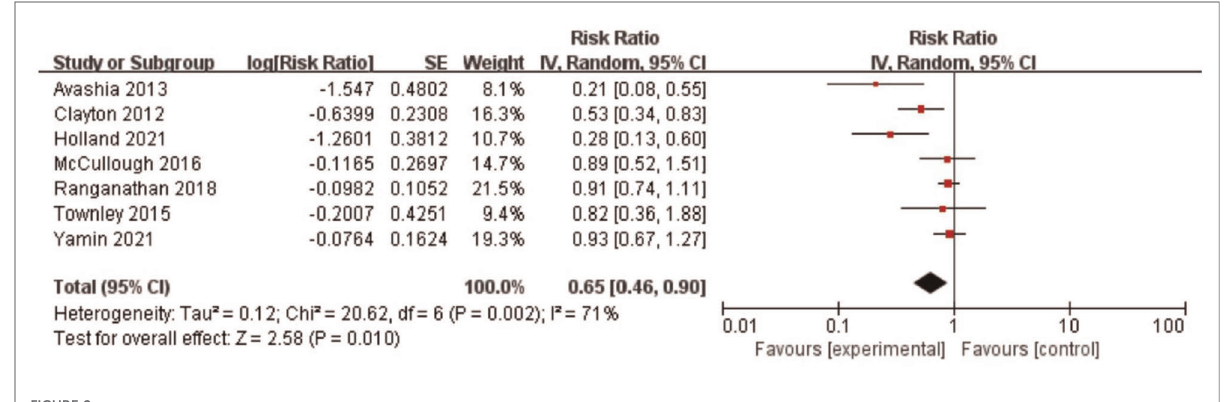
FIGURE 2 Forest plot for the relationship between antibiotic use and infection after breast implantation.